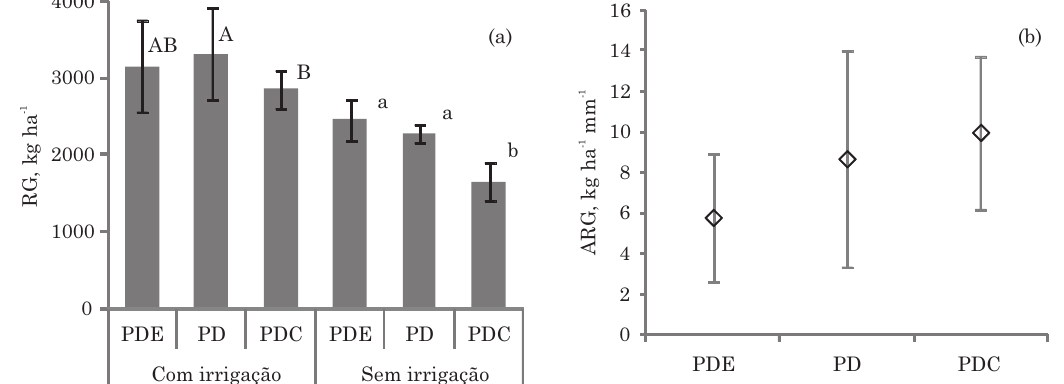
Figura 4. Rendimento de grãos (RG) (a) e acréscimo no rendimento de grãos (ARG) do feijoeiro com uso da irrigação (b). PD: plantio direto; PDE: plantio direto escarificado; e PDC: Plantio direto compactado. Barras verticais representam o desvio-padrão. Para cada nível de irrigação em separado, colunas seguidas de letras iguais não diferem entre si pelo teste de Tukey a 5